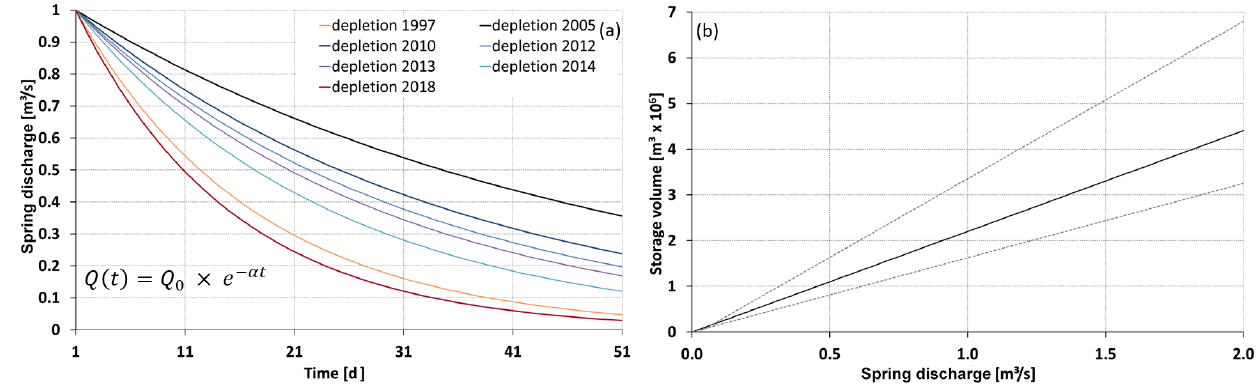
Figure 7. Depletion curves of the karst groundwater of RCZ for selected years (a) and calculated storage volumes of the groundwater body at different levels of spring discharge (b) . The solid line shows the relationship for a mean recession constant “ α ” of 0.4, and the dashed lines are enclosing the range of 1 standard